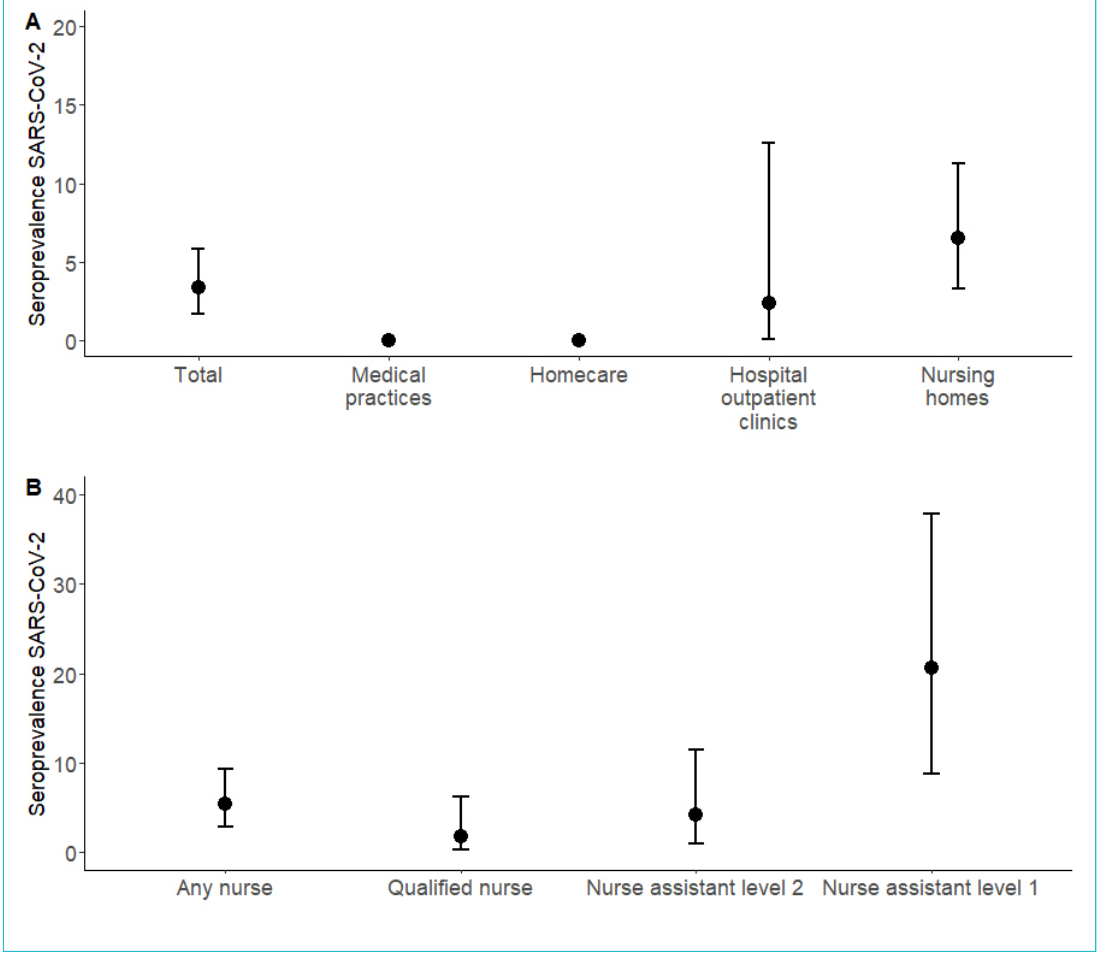
Figure 1: eSARS-coV-2 seroprevalence by (A) workplace and (B) among nurses (homecare, outpatient departments of the hospital, nursing homes). There were no events in the categories “medical practices” and